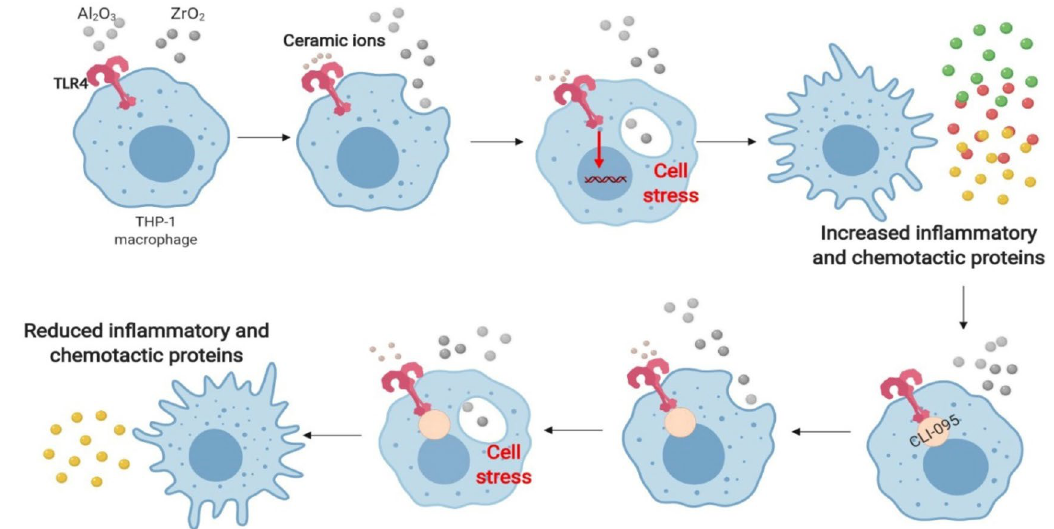
Figure 7. Working model of TLR4-mediated inflammation to metal oxide ceramic nanopowders. Ceramic ions released from metal ceramic oxide nanopowders activate TLR4 on macrophages. These macrophages are also capable of phagocytosing ceramic metal oxides which when combined with TLR4 activation causes cell stress and a pro-inflammatory phenotype characterised by inflammatory and chemotactic gene expression and protein secretion. CLI-095 binds intracellularly to TLR4 and prevents the recruitment of adaptor molecules for downstream signalling, therefore there is a reduced pro-inflammatory phenotype. Macrophages remain